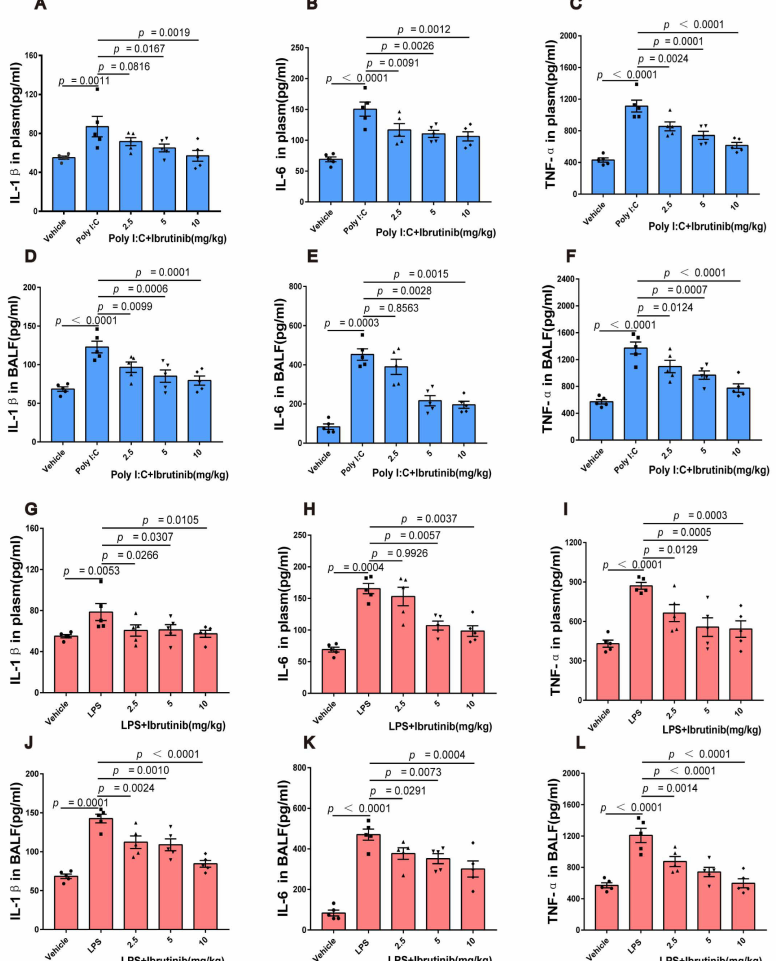
Figure 2. Effects of ibrutinib on inflammatory cytokine levels in poly I:C- and LPS-induced